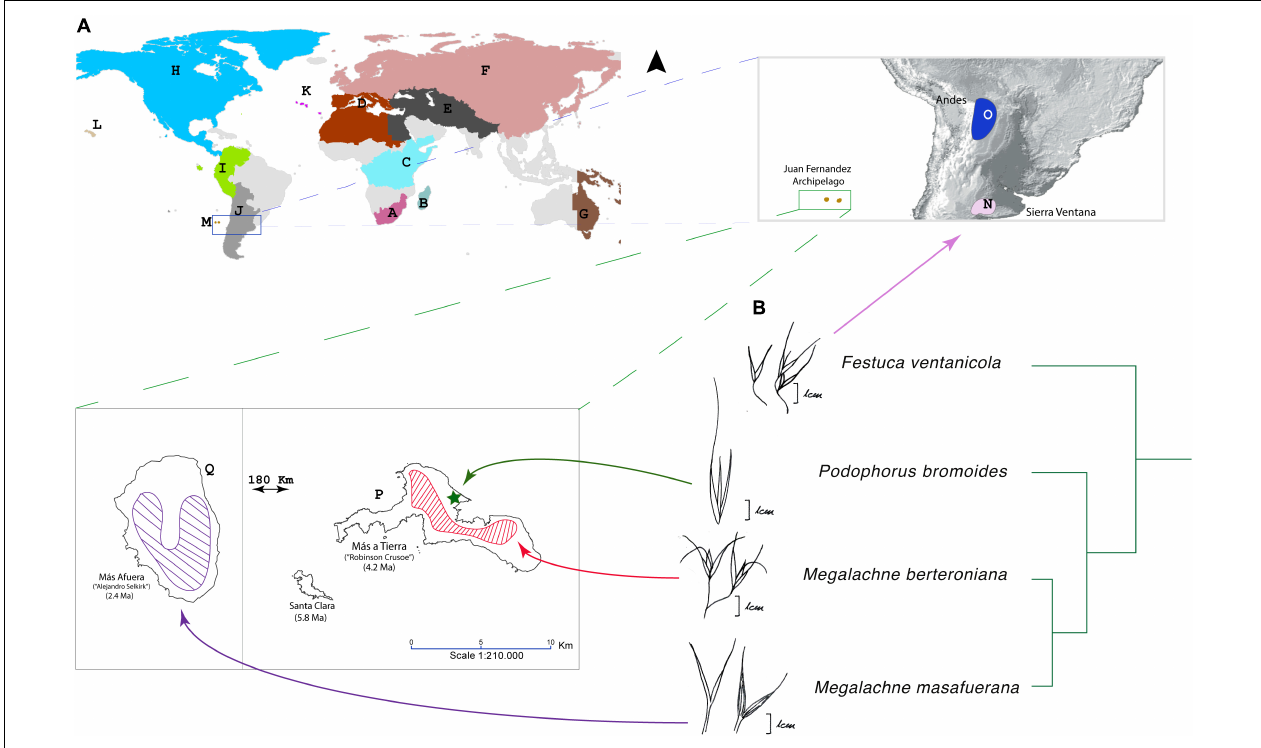
FIGURE 1 | (A) Distribution map of the Juan Fernandez archipelago Megalachne and Podophorus species included in this study [ M. berteroniana and M. masafuerana distributions have been obtained from Peña et al. (2017) and Penneckamp-Furniel and Villegas (2019); P. bromoides is tentatively mapped in the Cumberley bay of Masatierra; cf. Baeza et al. (2007)] and of the Pampean-Ventanian Festuca ventanicola , showing the world and the American-Vulpia-Pampas Operational areas (OAs) used in the biogeographical analyses of Loliinae. OAs: Loliinae DEC model: A – South Africa; B – Madagascar and Mascarenes; C – Tropical Africa; D – Mediterranean; E – Irano-Turanian-Himalayan region; F – Eurasia (Eurosiberian region); G – Australasia (New Zealand, south-western Australia, Papua-New Guinea); H – North and Central America; I – Northern Andes; J – Southern Andes and Southern South America; K – Macaronesia; L – Hawaii; M – Juan Fernández; American-Vulpia-Pampas DEC model: H – North and Central America; N – Pampas-Ventania; O – Andes; P – Masatierra; Q – Masafuera. (B) Phylogenetic ITS-TLF subtree showing the relationships of the Fernandezian Podophorus bromoides , Megalachne berteroniana , and M. masafuerana grasses and its close relative Festuca ventanicola ; drawns of the floral “vulpioid” phenotype are shown for each